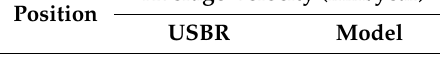
Table 9. Extensometer vs. model.